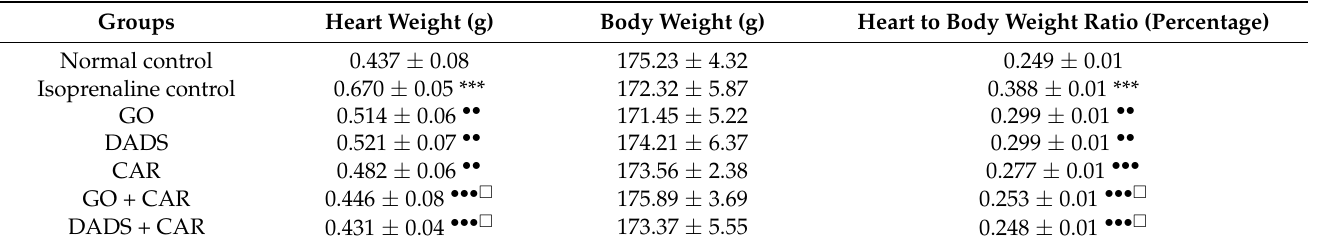
Table 1. Effect on heart weight and heart/body weight